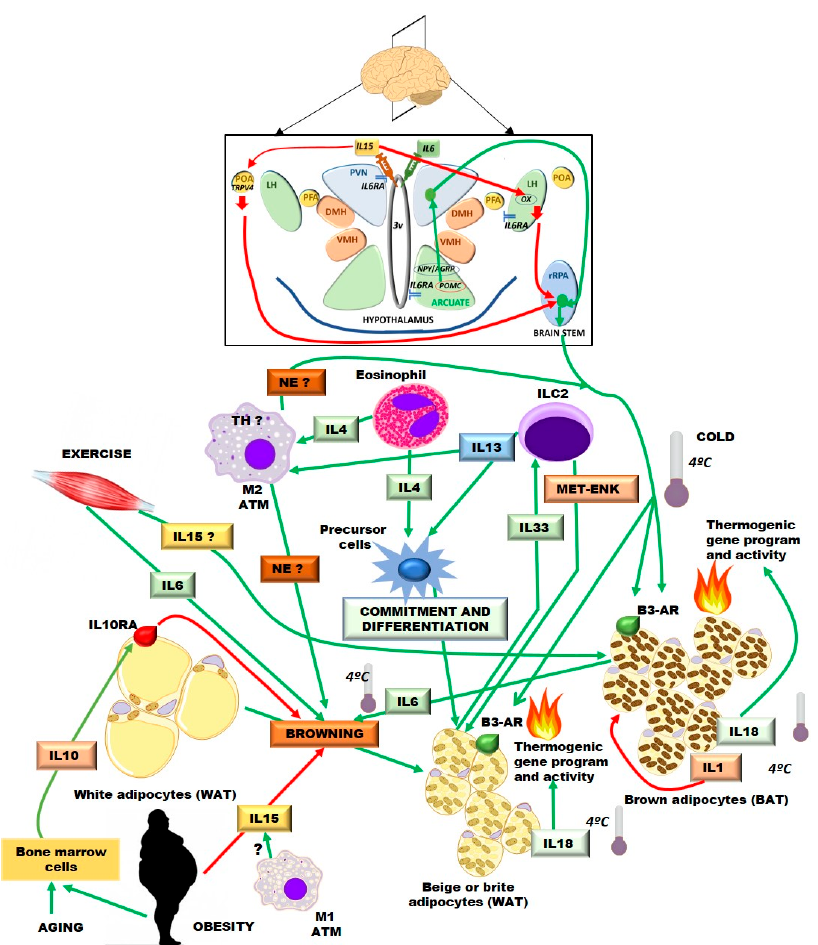
Figure 1. Main interleukins involved in the modulation of EE and BAT and beige adipose tissue thermogenesis through CNS or direct actions in brown adipocytes activation and WAT browning. In case of available data, tissue and cell sources of this immune mediators are also shown. Red or green lines and arrows depict inhibitory or stimulatory actions. Inset in the upper panel represents a scheme of the main hypothalamic and brain stem nucleus involved in the central regulation of ATs thermogenic function, namely: preoptic area (POA), dorsomedial (DMH), arcuate (ARC), paraventricular (PVH) and lateral nucleus of the hypothalamus (LH) as well as the rostral raphe nucleus (rRPA) at the brain stem. Hypothalamic mediators at these nuclei include: agouti-related protein (AgRP), neuropeptide Y (NPY) and proopiomelanocortin (POMC) at the ARC, orexin at the LH and transient vanilloid rector 4 (TRPV4) at the POA. IL6 and IL15 are known to activate or inhibit these central pathways. rRPA receives input from the different hypothalamic areas to activate sympathetic projections to ATs acting at β 3 adrenoceptors (B3-AR). Some interleukins are directly produced by resident or recruited immune cells, including: adipose tissue macrophages (ATMs, M2-alternative and M1-classically activated), eosinophils and type 2 innate lymphoid cells (ILC2) to stimulate WAT browning through commitment and differentiation of precursor cells at this site. The ability of M2-ATMs to produce catecholamines (tyrosine hydroxylase, TH) to sustain adaptive thermogenesis is under debate. Several stimuli have been reported to trigger or inhibit both mechanisms including among others stimulation by cold exposure and exercise, while others such as obesity and aging exert the opposite effect. Question marks depict mechanisms unknown or under debate. Methionine-enkephalin